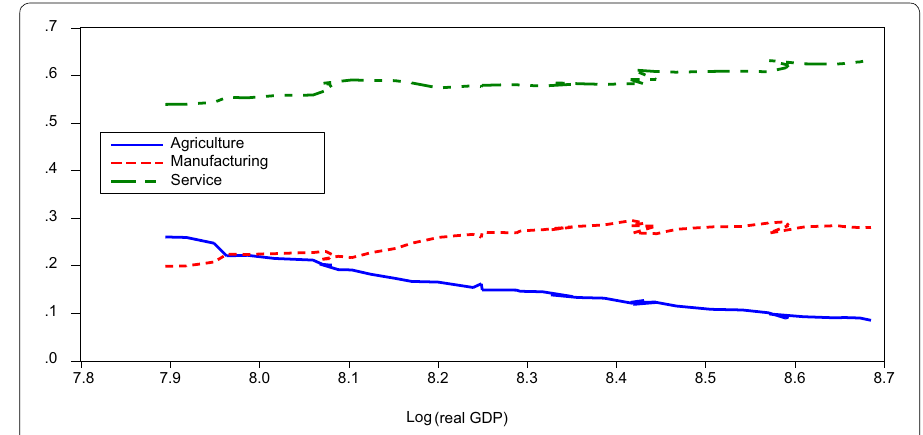
Fig. 7 Sectoral shares of value-added in the three sectors, and GDP in Turkey (annually, 1970–2015). Source : Author’s calculation. Value-added (2005 100) was derived from UN data (US dollars). For additional informa- = tion see Fig. 2